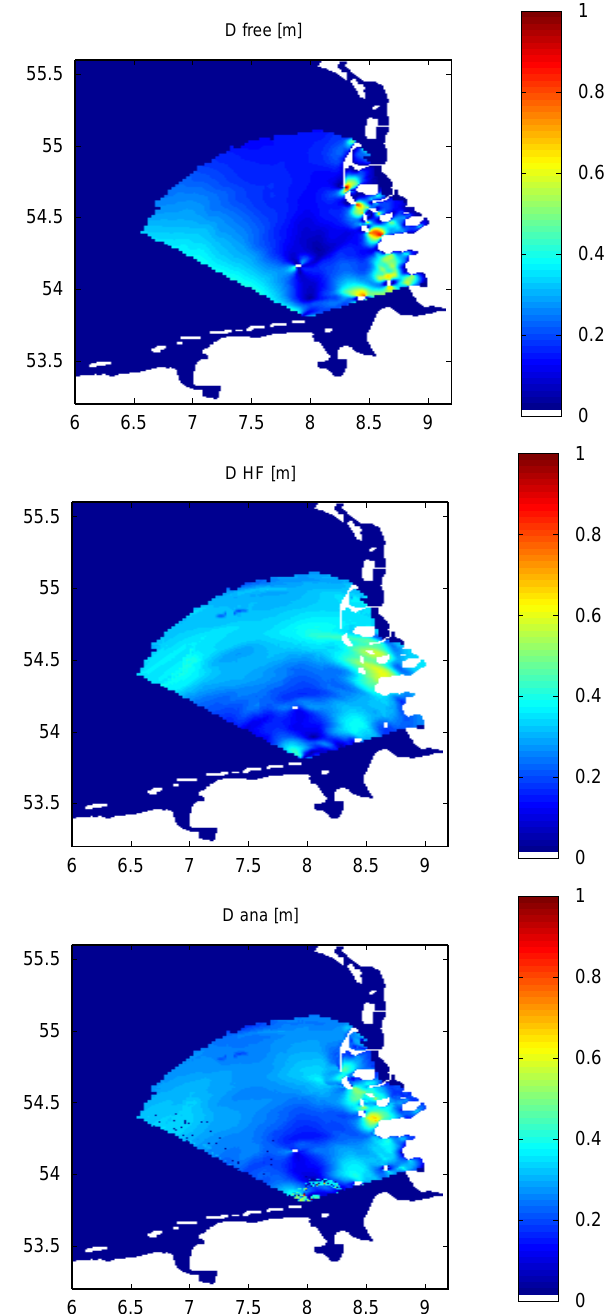
Fig. 12. Radial velocity amplitude D for the free run (top), the radar observations (centre), and the analysis (bottom) estimated for Nov 1, 2009.